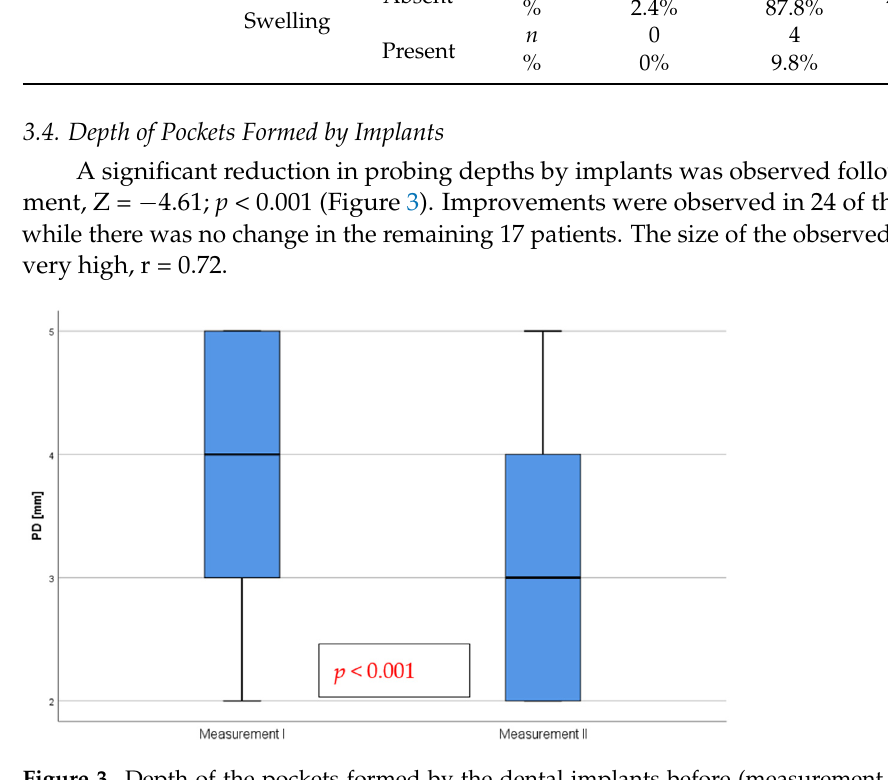
Figure 3. Depth of the pockets formed by the dental implants before (measurement I) and after treatment (measurement II) with a bioactive healing abutment containing clindamycin. treatment (measurement II) with a bioactive healing abutment containing